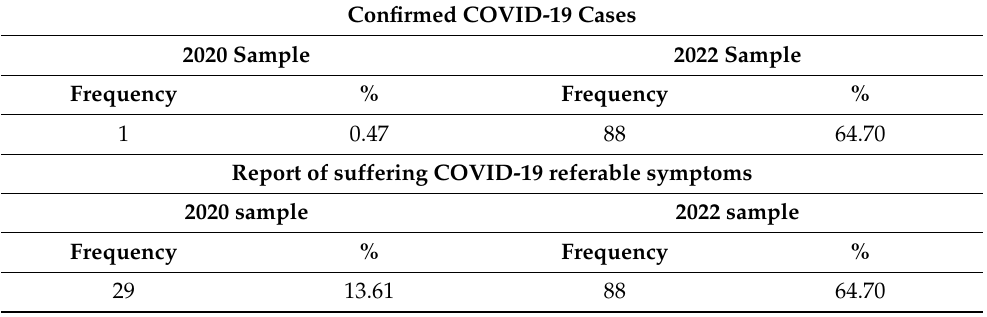
Table 2. COVID-19 presence in study participants.